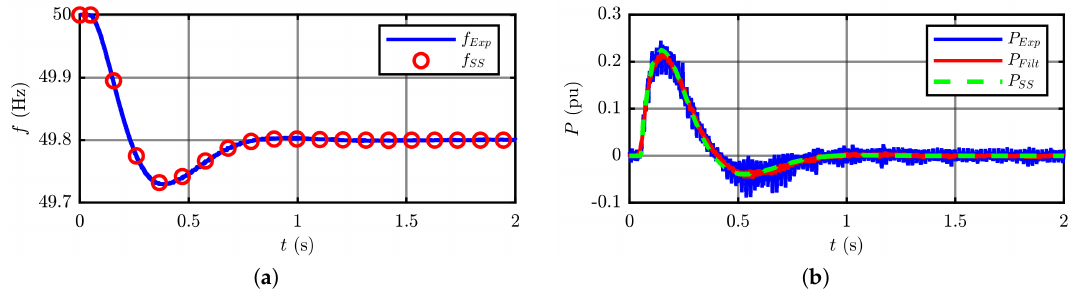
Figure 13. Test 3: Grid frequency step drop ∆ ω g from 50 Hz to 49.8 Hz. From left to right: ( a ) S-VSC virtual rotor speed ω r (Hz) from experimental test (Exp) and state-space model (SS); ( b ) Active power injected into the grid (pu) from experimental test (Exp), filtered active power (Filt) and output of the state-space model (SS).